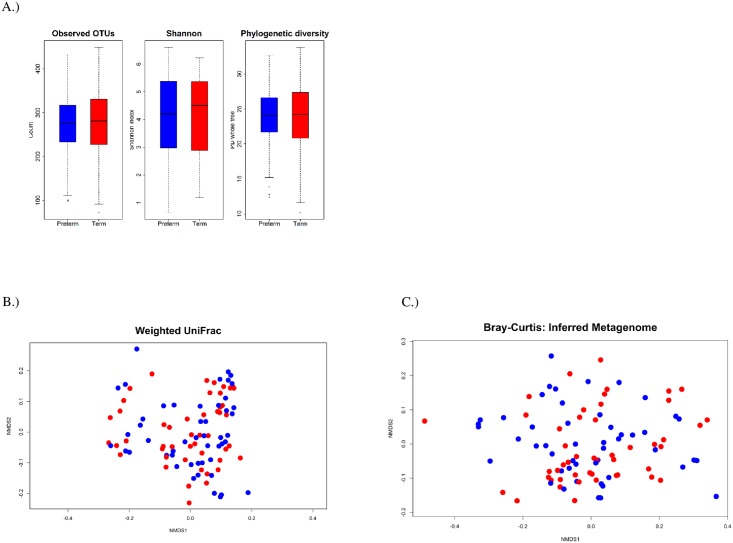
α-diveristy estimates and non-metric dimensional scaling (NMDS) comparing community compostion as meaured by the weighted UniFrac metric and Bray-Curtis dissimialrty for the inferred metagenome for mothers delivering at term (red) or preterm (blue).(A) Box-plots for α-diveristy estimates (P value >0.76 for all models). (B) NMDS of the weighted UniFrac metric (stress = 0.16; p = 0.78 for clustering by PTB). (C) NMDS of the Bray-Curtis dissimialrity on the inferred metagenome (stress = 0.11; p = 0.82 for clustering by PTB).